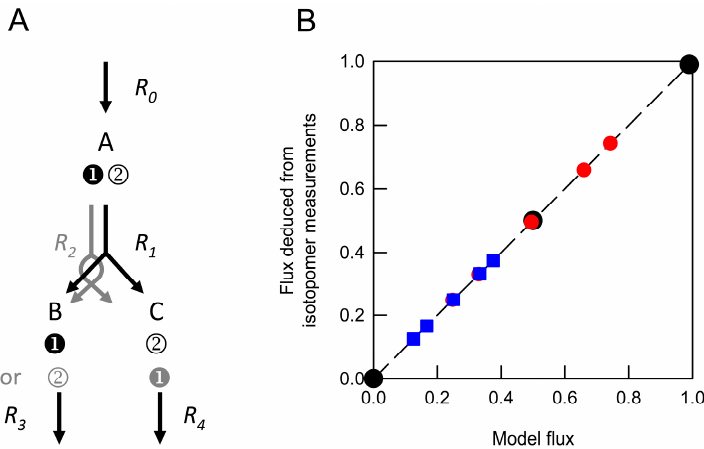
Figure 1. Reliability of flux estimates in a network containing a single variable flux. ( A ) Model network in which carbon atoms in intermediate A are transferred to products B and C in different ways through the activities of alternative irreversible reactions ( R 1 and R 2 ). The isotopomer compositions of the metabolic intermediates B and C were determined when flux through R 1 was varied. ( B ) Fluxes were deduced from individual isotopomer datasets ( ● ) and from weighted average datasets generated by combining values obtained from networks in which R 1 net was 0 and 1.0 ( ● ) or 0 and 0.5 ( ■ ). These were compared with the anticipated model flux based on the relative contributions of different networks to the isotopomer dataset. Each deduced flux value is the mean of 100 Monte Carlo simulations for which the SD is smaller than the symbol. The dashed line indicates equivalence between the deduced flux estimate and model flux.